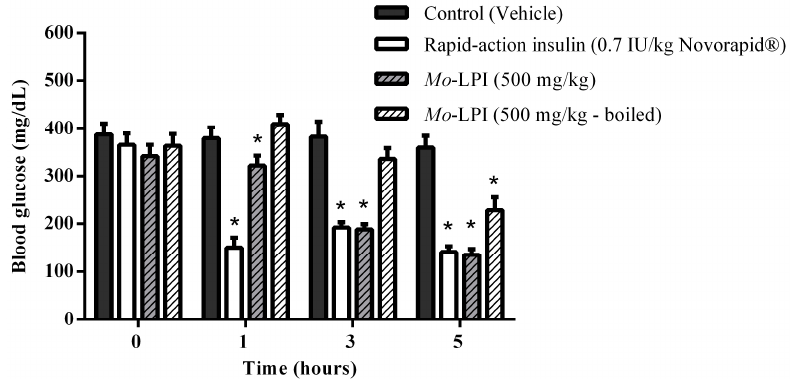
Figure 5. Influence of temperature on the hypoglycemic activity of Mo -LPI administered to alloxan-induced diabetic mice by intraperitoneal injection. Values are means ± S.E.M. ( n = 10). Control: vehicle (0.05 M Tris-HCl, pH 7.5, containing 0.15 M NaCl). Mo -LPI unheated and previously boiled to 98 °C for 1 h. * Significant ( p < 0.01) difference when compared with the corresponding value of the control at the same time.